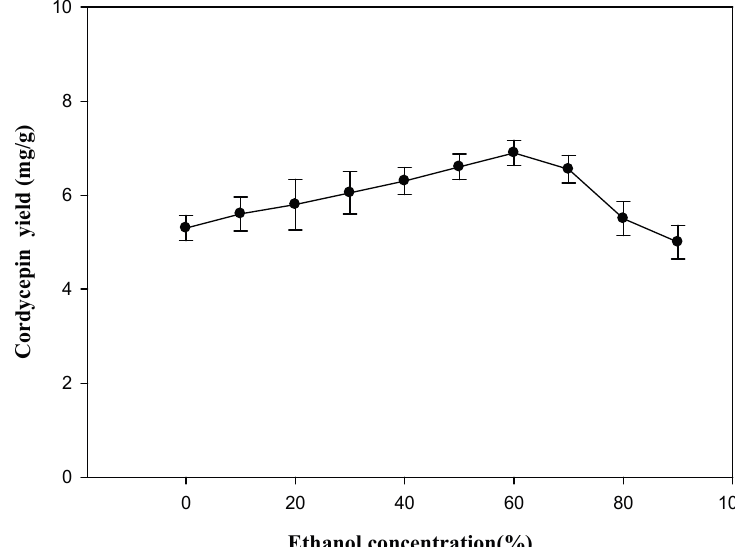
Figure 3. Effect of ethanol concentration on the extraction yield of cordycepin from C. militaris . Extraction time: 50 min; extraction temperature: 60 °C; ratio of liquid to solid: 20 mL/g; extraction frequency: 40